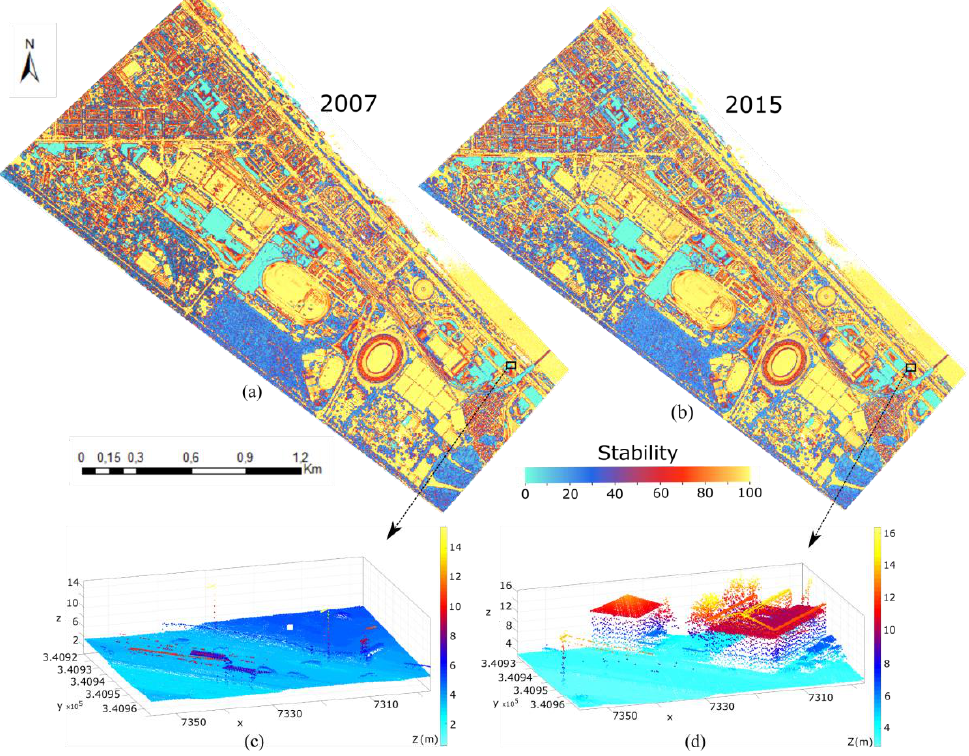
Figure 4. Cont. Figure 4.